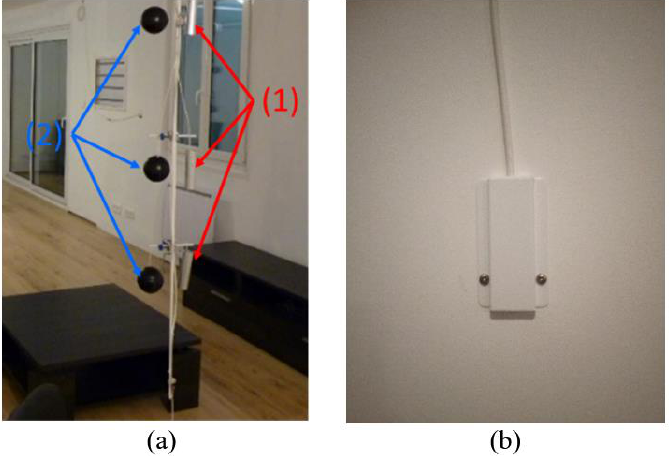
Figure 10. Sensors in the experimental facility. ( a ) a measurement mast. ( b ) a wall temperature sensor.